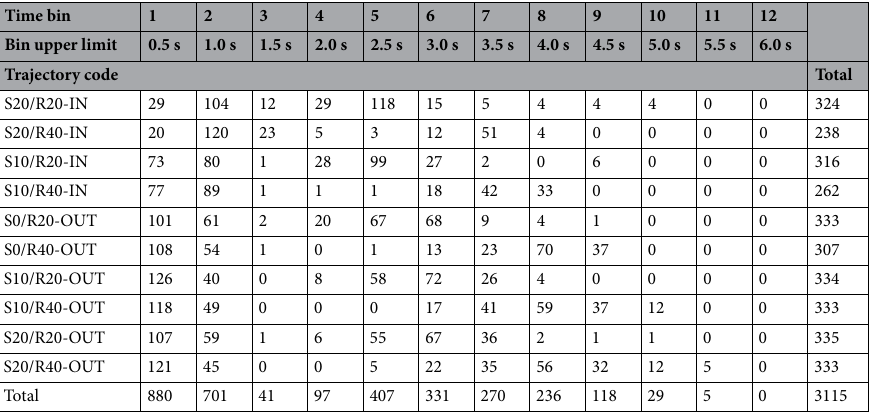
Table 2. Number of steering events observed over all 1659 retained trials for each of the 10 different target trajectory conditions per time bin of 0.5 s duration from the onset of a trial